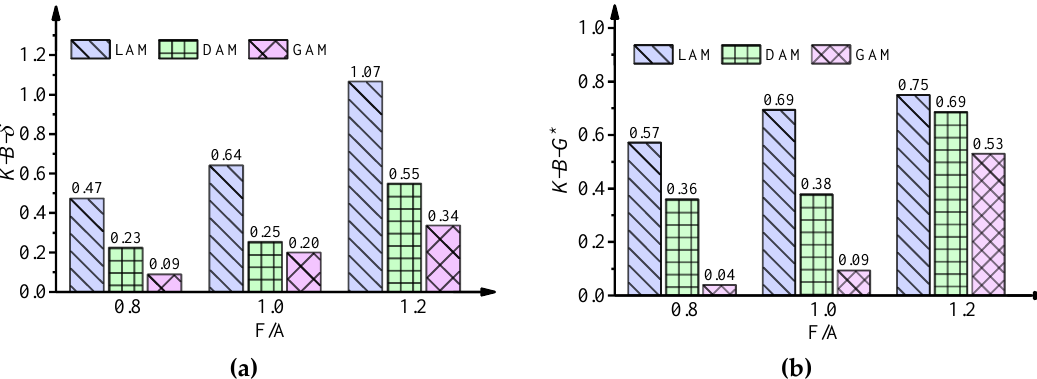
Figure 2. Change trends of K-B- 𝛿 and K-B- 𝐺 ∗ of three asphalt mastics with different F/A ratios and loading frequencies. ( a ) K-B- 𝛿 curves frequency ; ( b ) K-B- 𝐺 ∗ curves frequency .